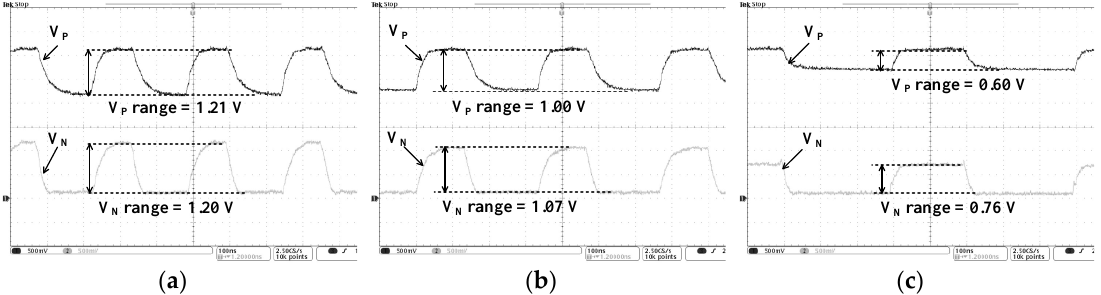
Figure 8. Measured power MOSFET gate voltage swing with bias control: ( a ) I LOAD : over 100 mA, ( b ) I LOAD : from 50 mA to 100 mA and ( c ) I LOAD : under 50 mA.